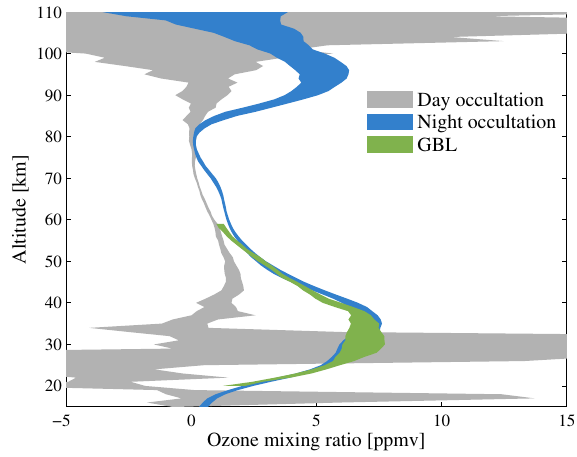
Figure 6. Example of the vertical distribution of ozone from the GOMOS night/day occultations and GBL. Data from January 2005, latitude 35 ◦ N (zonal medians and interquartile